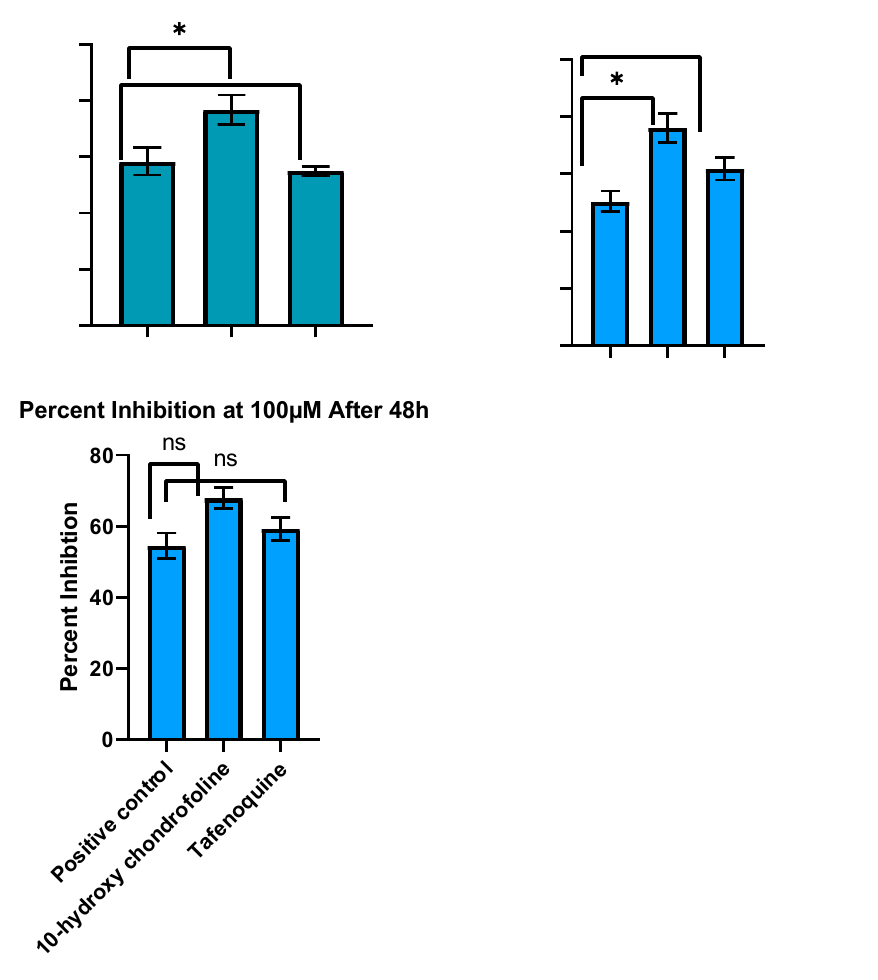
Figure 4. Percent inhibition (against amastigotes, in vitro ) 48 h post-treatment with the test compounds at 25, 50, and 100 µ M, respectively. Data are expressed as mean ± standard deviation ( n = 3). * p > 0.05, ns = not significant.